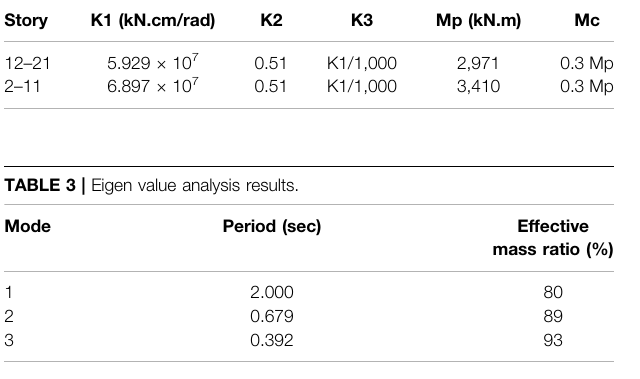
Frontiers in Built Environment |